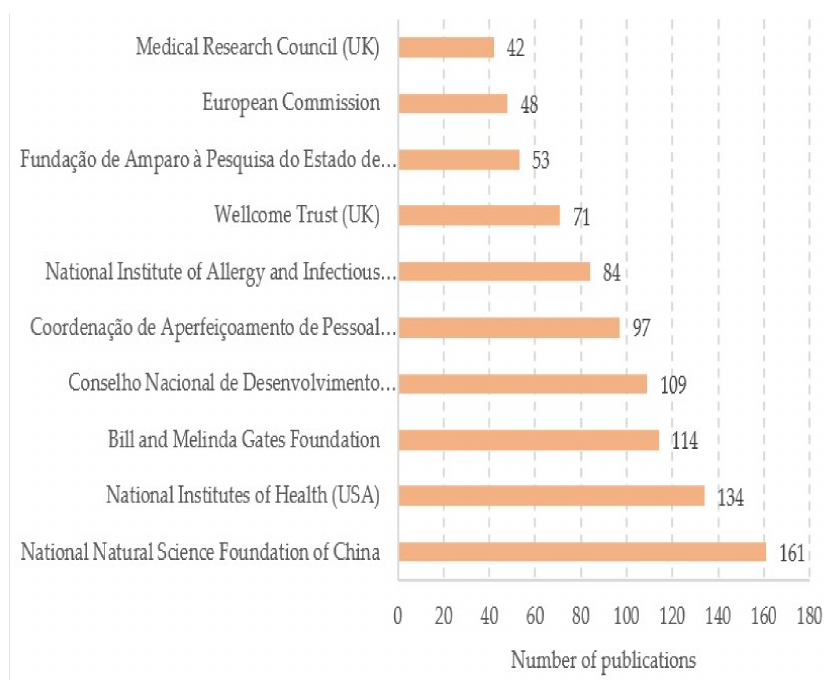
Figure 6. Co-authorship network.